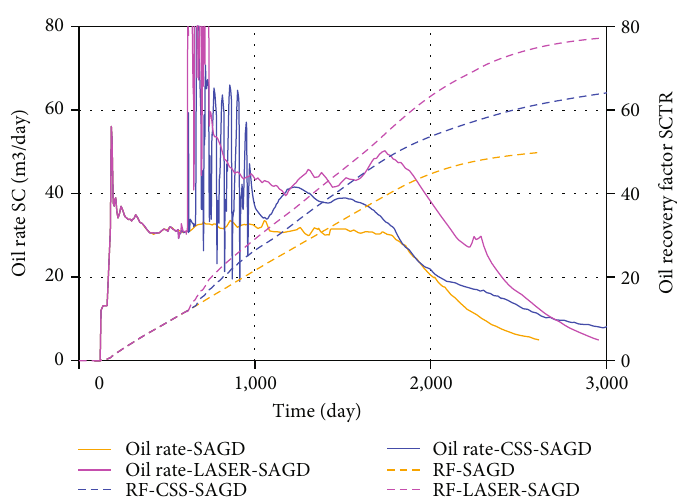
Figure 19: Production performance comparison for di ff erent recovery